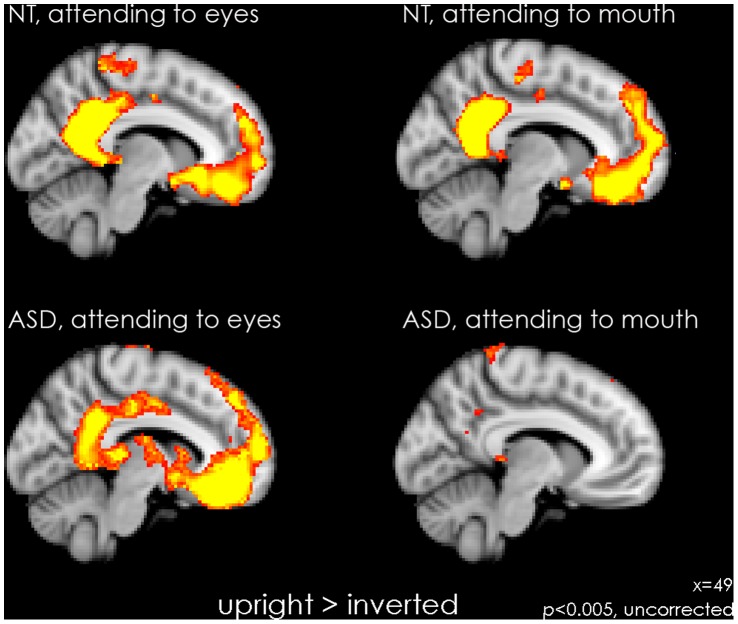
Cortical and subcortical activation for within-group whole brain analysis.Statistical maps of increased activation for each group for the contrast upright vs. inverted, showing areas of subcortical activation, displayed on the FSL MNI template at a sagittal slice x = 49. The two left panels show activation for the condition where participants are attending to the eye-region to perform the task (top panel: NT; bottom panel: ASD). The two right panels show activation for the condition where participants are attending to the mouth-region to perform the task (top panel: NT; bottom panel: ASD). Data are thresholded with p<0.005, uncorrected, for visualization purposes. When cued to the eyes, both groups showed activation in medial prefrontal cortex and posterior cingulate/precuneus cortex. In addition, ASD showed activation in subcortical structures. When cued to the mouth ASD do not show activation in medial prefrontal cortex and posterior cingulate/precuneus cortex.